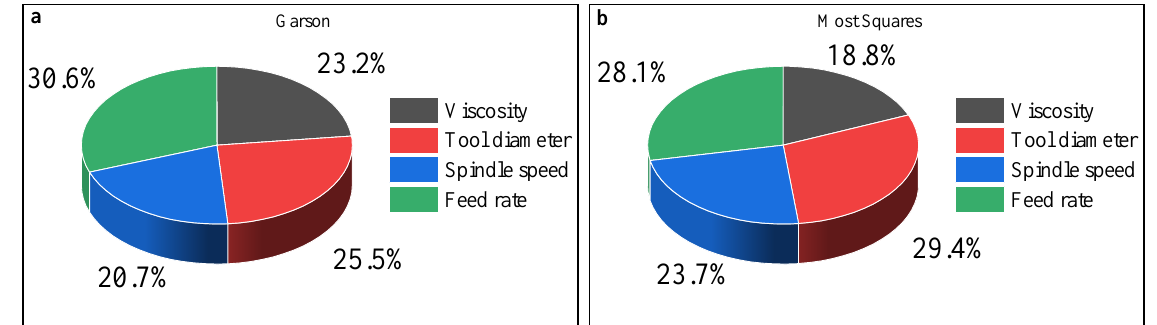
Figure 12. Relative importance of different input variables according to the ( a ) Garson and ( b ) Most-Squares algorithms.